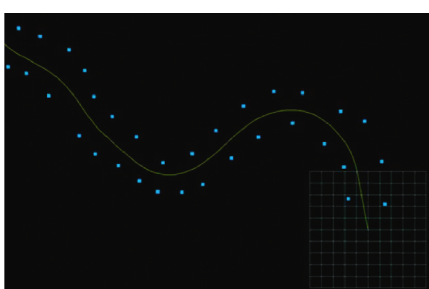
Figure 21: Expected trajectory curve.